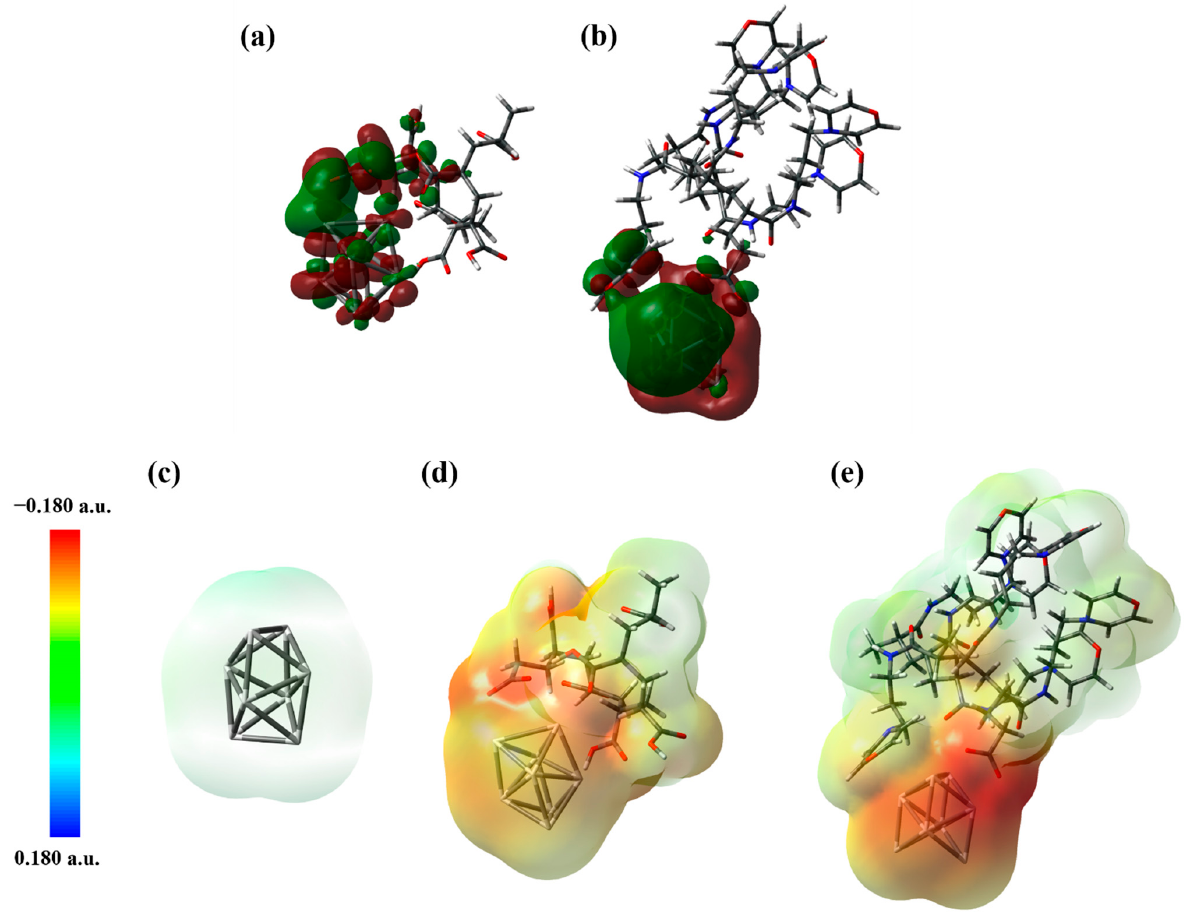
Figure 2. Contour plots (isovalue: 0.01 e Å − 3 ) of molecular orbitals with the largest bonding contribution for ( a ) PAA/Ag 8 (MO = 207), ( b ) MPA-PAA/Ag 8 (MO = 398) and electrostatic potential (ESP) mapping of ( c ) Ag 8 cluster, ( d ) PAA/Ag 8 and ( e ) MPA-PAA/Ag 8 .